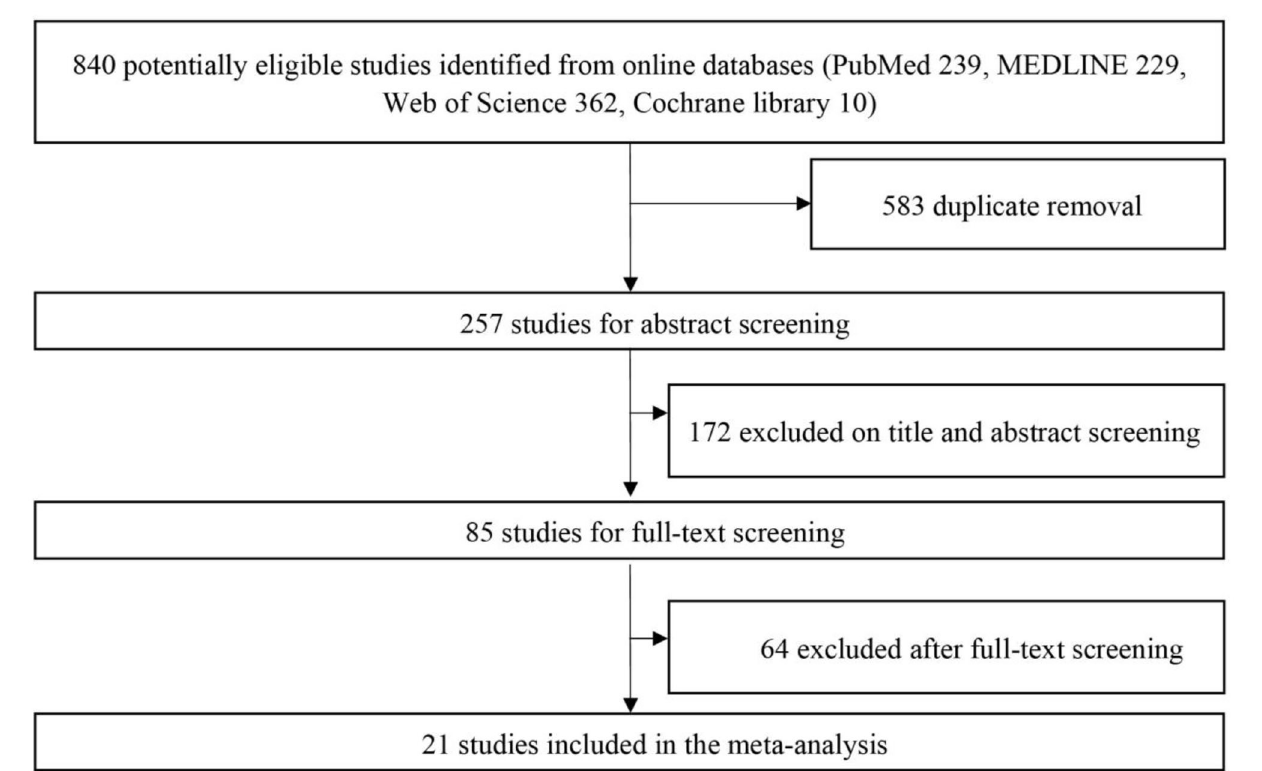
FIGURE 1 | Algorithm of literature retrieval and study